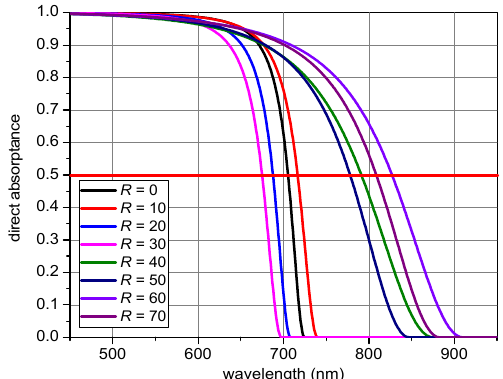
Figure 6. Direct absorptance according to the Yablonovitch concept (Equation (1)). The line at A ( λ ) = 0.5 indicates the benchmark wavelength.